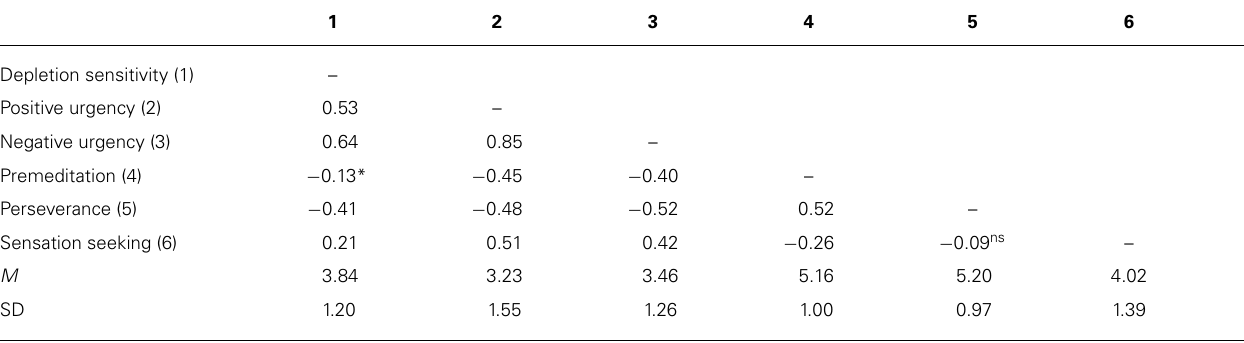
Table 2 | Means, SD and correlations of the DSS with subscales of the UPPS + P Impulsive Behavior Scale, Study 2. 1 2